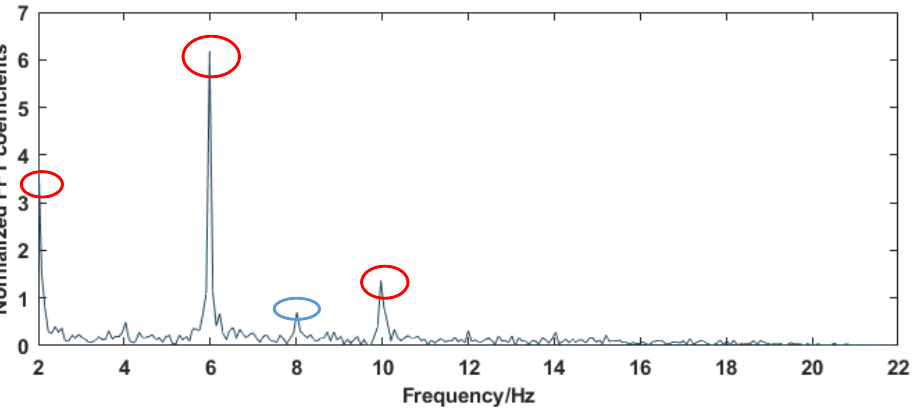
Figure 6. POSE TWO ’ s FFT curve. Figure 6. POSE TWO’s FFT